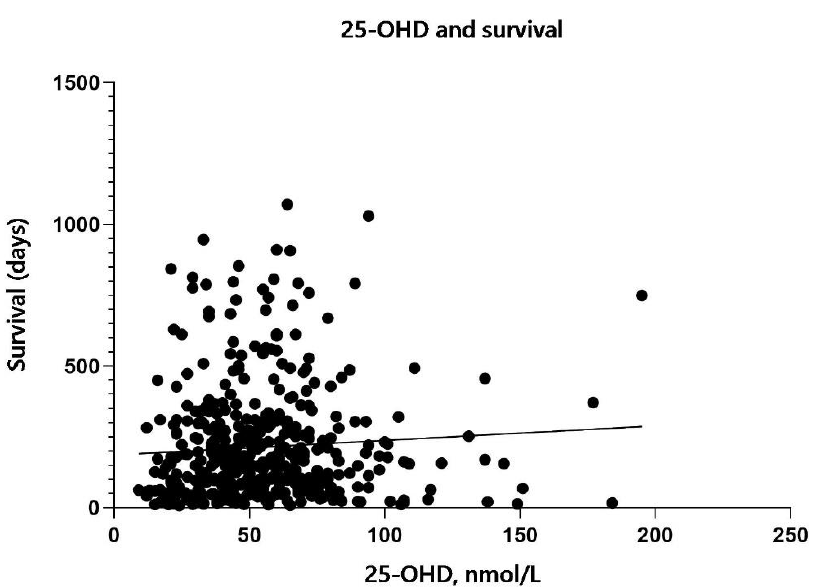
Figure 6. Median 25-hydroxyvitamin D (25-OHD) values in nmol/L in deceased patients from the screening cohort ( n = 440) of the ‘Palliative-D’ study plotted against survival time in days.